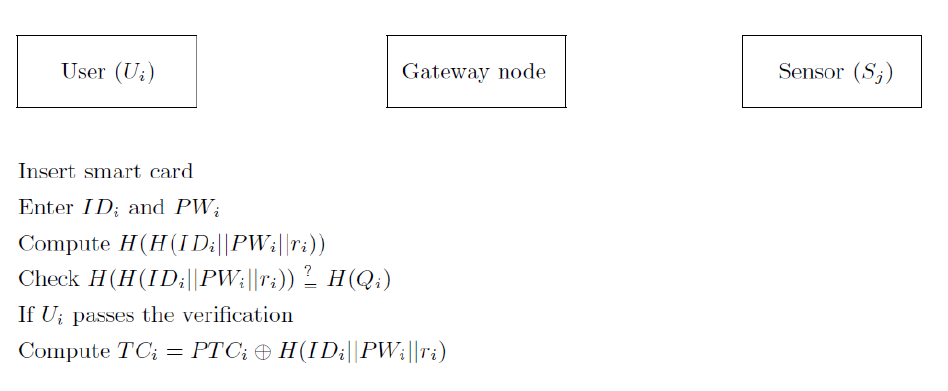
Figure 2. Communication handshakes of the registration phase of sensor node S